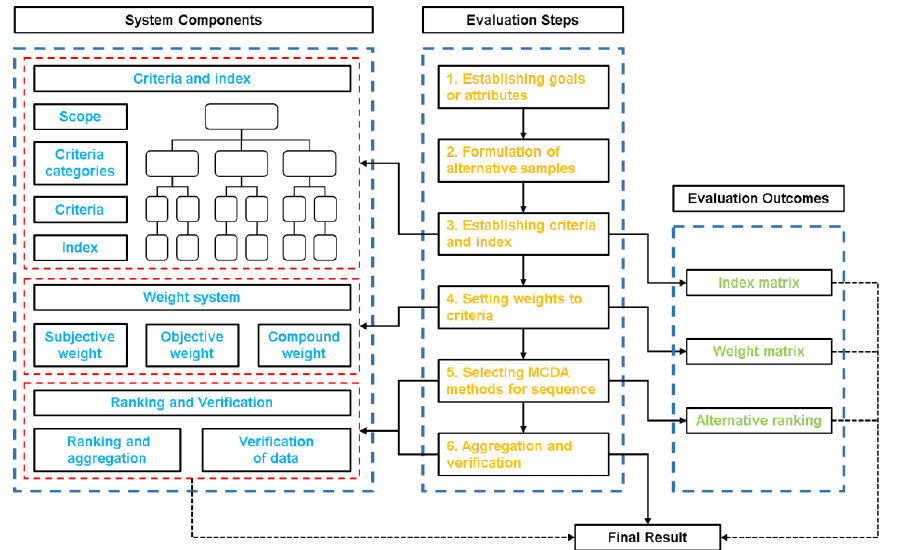
Figure 1. Operation process and system composition of MCDA.